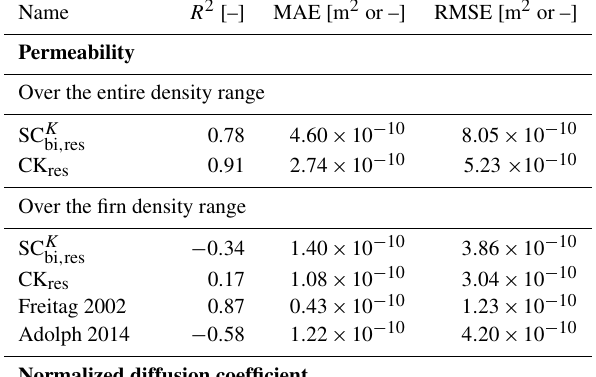
Table 2. Correlation of determination R 2 , mean absolute error MAE, and root mean squared error RMSE values obtained between predicted values from models or regressions and true values, the data being computed from 3D images, for permeability and effec- tive coefficient of diffusion, obtained when considering all samples and firn samples only. MAE and RMSE are indicators of the aver- age difference of the modeled values with respect to the true data. RMSE has a higher weight for outliers than MAE, which treats all differences equally. In addition to the average difference between modeled and true data, R 2 also indicates how well the model de- scribes the trend seen in the true data ( R 2 values close to 1 indicate that average differences between model and truth are small and that the true data are equally scattered around the model across the full